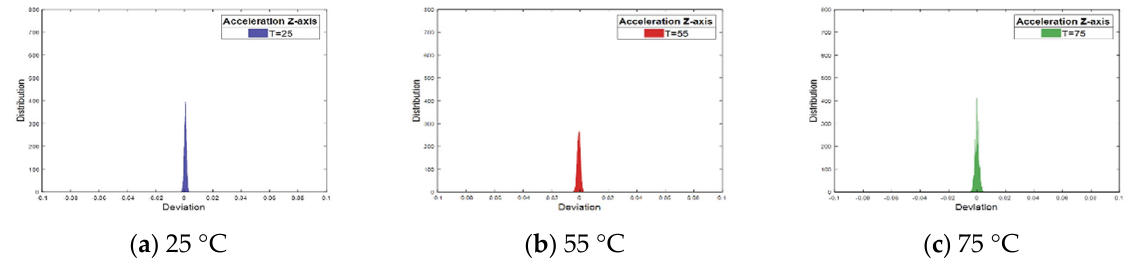
Figure 9. Noise distribution chart of the Z ‐ axis of the accelerometer.